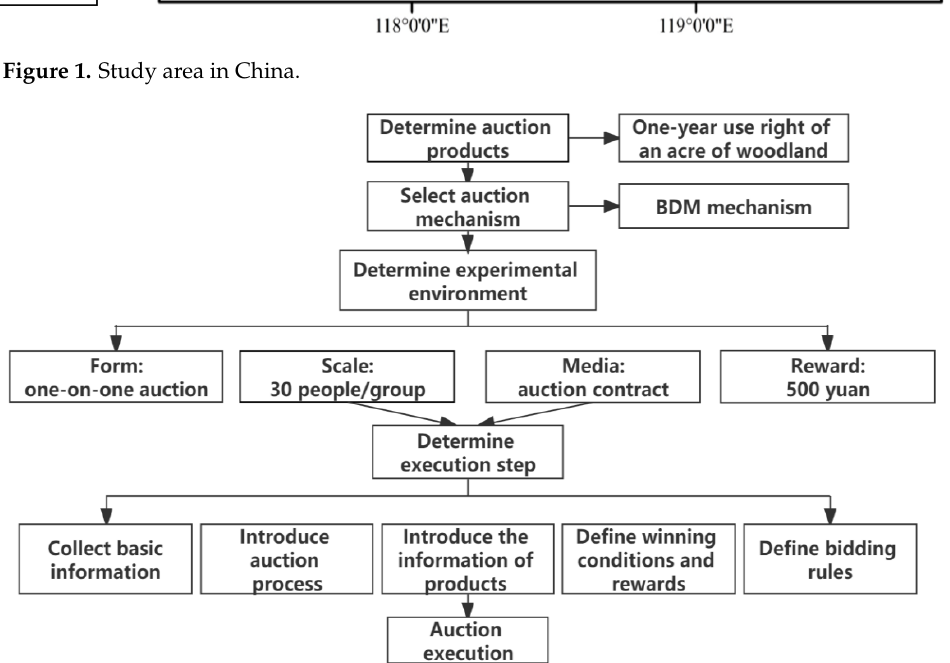
Figure 2. Auction experimental design framework.